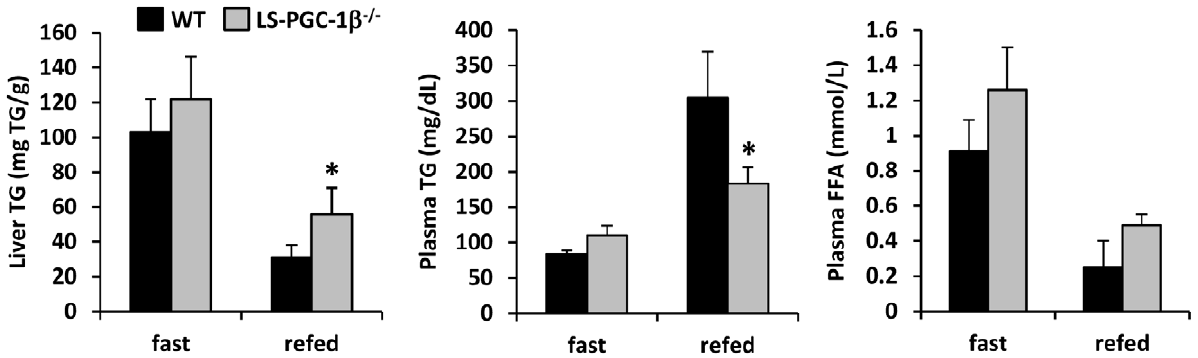
Figure 5. Increased hepatic and circulating TG content in LS-PGC-1 b 2 / 2 mice in response to fasting-refeeding. The graphs depict hepatic TG content, circulating TG concentration, and plasma free fatty acid concentration in WT and LS-PGC-1 b 2 / 2 mice after 40 h food deprivation or 24 h fasting and then refeeding for 16 h with high sucrose diet. *P , 0.05 versus WT mice.